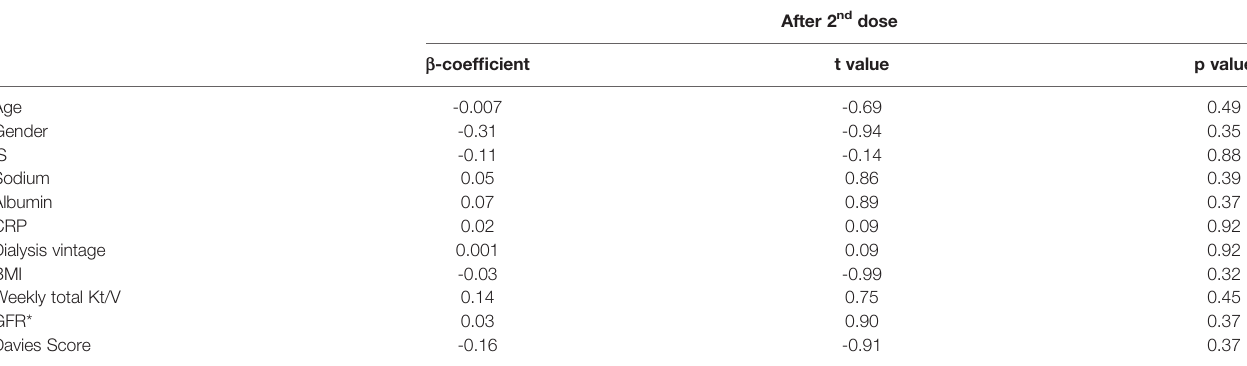
TABLE 4 | Effects of the antibody titer after the 1 st dose and other covariates on the antibody titer after the 2 nd dose of mRNA-1273 SARS-CoV-2 vaccine (multivariate